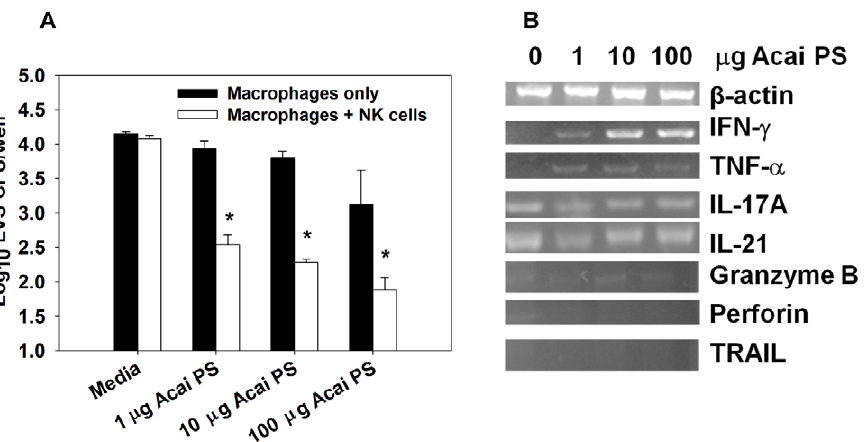
Figure 2. Acai PS enhances LVS clearance from in human primary macrophages and enhances NK cell IFN- c mRNA. Human primary macrophages (1 6 10 4 cells/well, 3 wells/treatment) were derived from PBMCS and infected with LVS (MOI , 300). One day prior to macrophage infection, autologous NK cells were also isolated via magnetic sorting. Macrophages and NK cells were treated separately with varying amounts of Acai PS 16 h prior to macrophage infection. After infection of the macrophages, fresh media with or without Acai PS or fresh media containing NK cells ( , 20 NK cells/macrophage) with or without Acai PS were then added to the macrophage containing wells. A) Twenty h after infection, NK cells (non-adherent) were removed, macrophages were lysed, and intracellular bacteria enumerated. Error bars represent standard error. *P , 0.05, as compared to untreated macrophages. B) Total RNA was extracted from NK cells co-cultured with LVS-infected macrophages (with or without Acai PS), and RT-PCR was performed for b -actin (control) and IFN- c , TNF- a , IL-17A, IL-21, granzyme B, perforin, and TRAIL. Results are representative of independent experiments from five different blood donors.